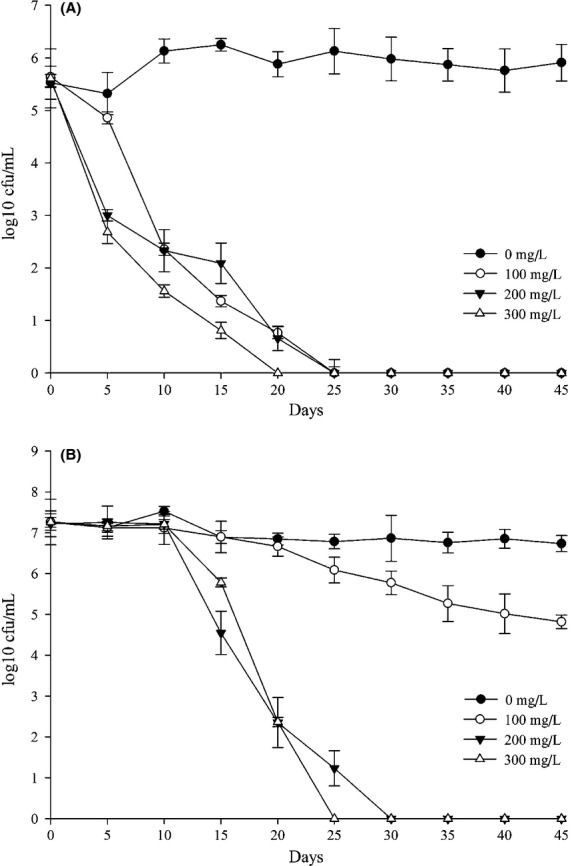
Inhibition of lysozyme on spontaneous LAB (A) and commercial LAB (B) (L. plantarum VT12 and O. oeni VP41 in 1:1 inoculation ratio). LAB inhibition was measured during 45 days in contaminated ice wine with the lysozyme addition of 0 (full circle), 100 (empty circle), 200 (full triangle), and 300 (empty triangle) mg L-1. Bars showed standard deviations.